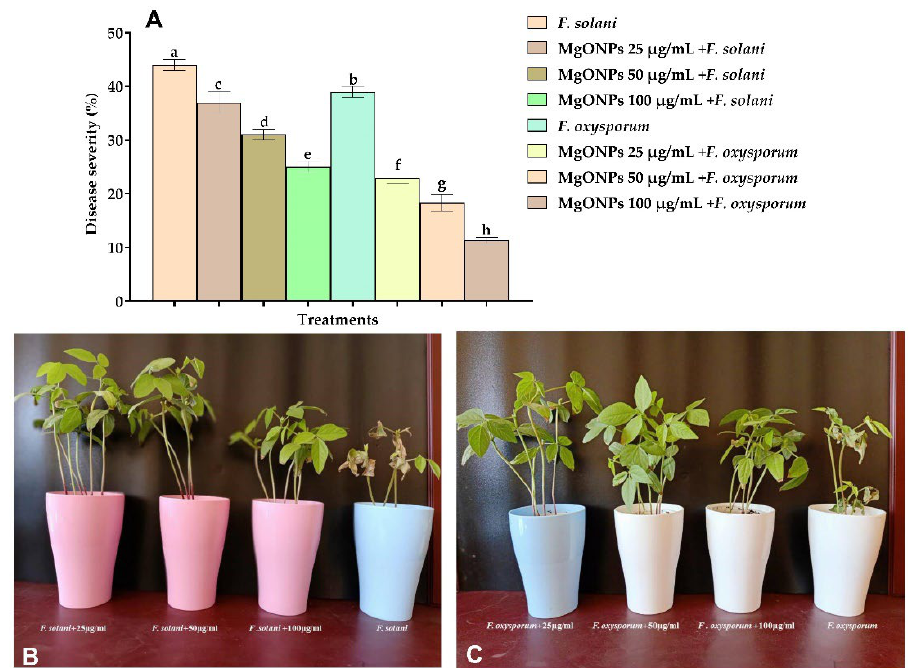
Figure 3. The impact of MgONPs on the disease severity of ( A ) F. solani ( B ) and F. oxysporum ( C ) in mung bean plants. a–h Columns with different superscripts are significantly different at p < 0.05.